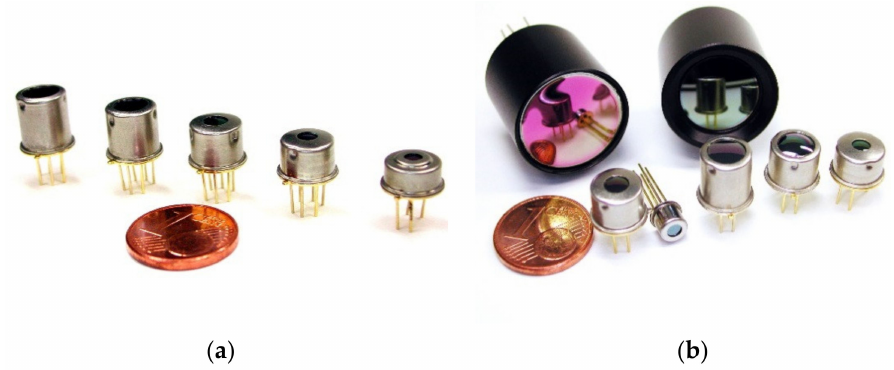
Figure 8. ( a ) Di ff erent optics and enclosures of the thermopile array sensors; ( b ) thermopile array sensors in di ff erent resolutions ranging from 8 × 8 to 120 ×